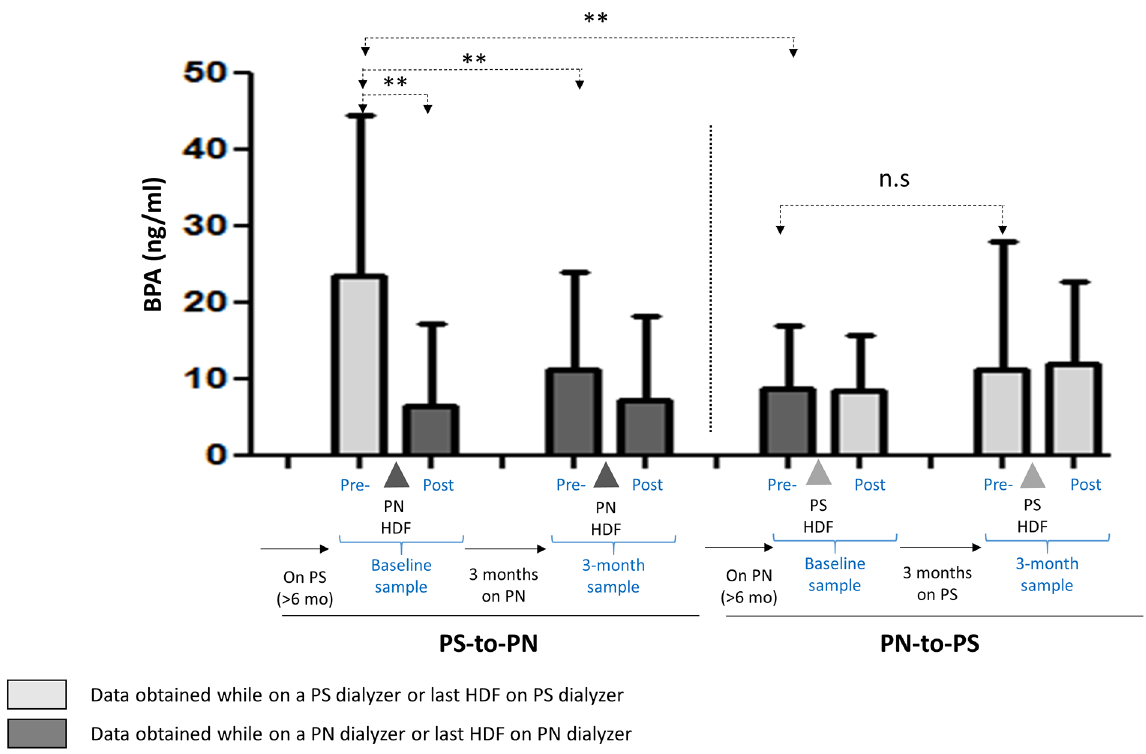
Fig 4. Plasma BPA concentration in patients on OL-HDF with polynephron (PN) or polysulfone (PS) membranes. Pre- and post-dialysis measurements are shown for the first (baseline) and the last (3-month) session after the switch. Prior to the baseline pre-dialysis sample, patients had been on OL-HDF with the opposite membrane for > 6 months. Thus, baseline pre-dialysis values represent values corresponding to > 6 months OL-HDF with the opposite membrane and were used as baseline values for the switch study, while baseline post-dialysis values were already obtained after the first session with the switch membrane. Data expressed as mean ± SD. (cid:3)(cid:3) p < 0.01. Pre- and Post- refers to pre-dialysis and post-dialysis (OL-HDF)